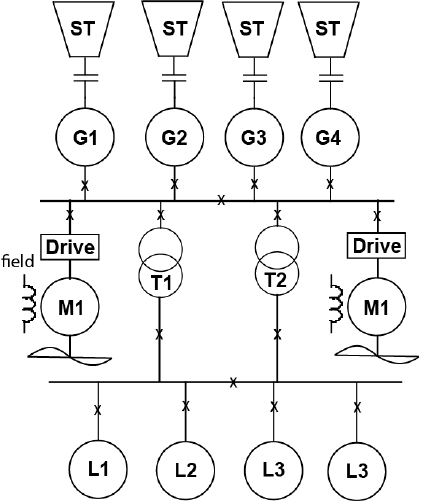
Figure 2. Radial power distribution for integrated propulsion system (IPS) architecture (T—Transformer).